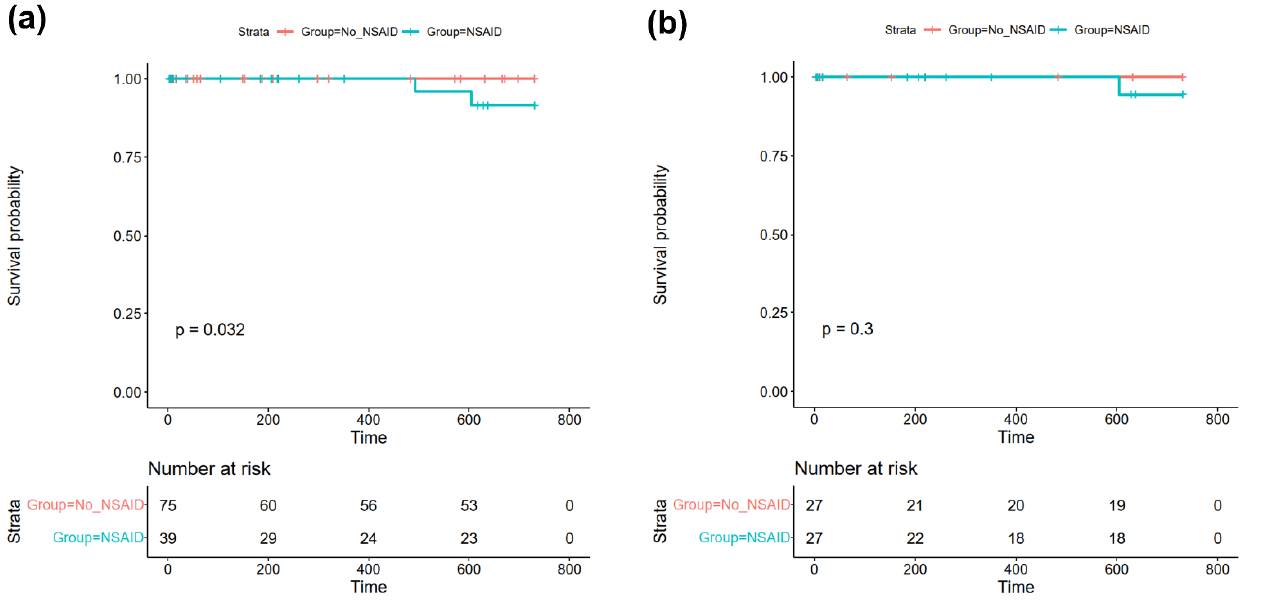
Figure 1. Kaplan–Meier plots of all-cause mortality within 24 months of follow-up in ( a ) the total study cohort and ( b ) the matched cohort after propensity score matching. Abbreviations: NSAID = non-steroidal anti-inflammatory drug. Table 3. Data on the primary and secondary study endpoints in patients of both groups prior to propensity score matching.